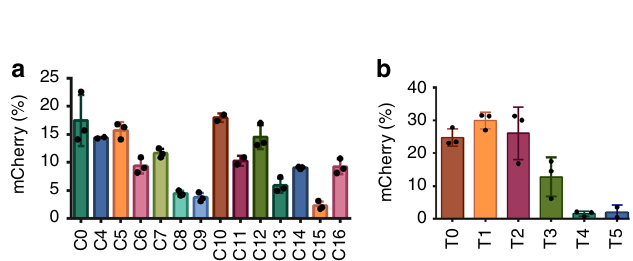
Fig. 2 Second round of chemical optimization of CRISPR RNAs. The optimized crRNA designs are shown in a , whereas chemical designs of tracrRNA are shown in b . Each crRNA was tested with the unmodi fi ed tracrRNA T0 , whereas each tracrRNA was tested with the unmodi fi ed crRNA C0 . The bar graphs show the percent of cells expressing mCherry, ±SD. Each RNA was tested in